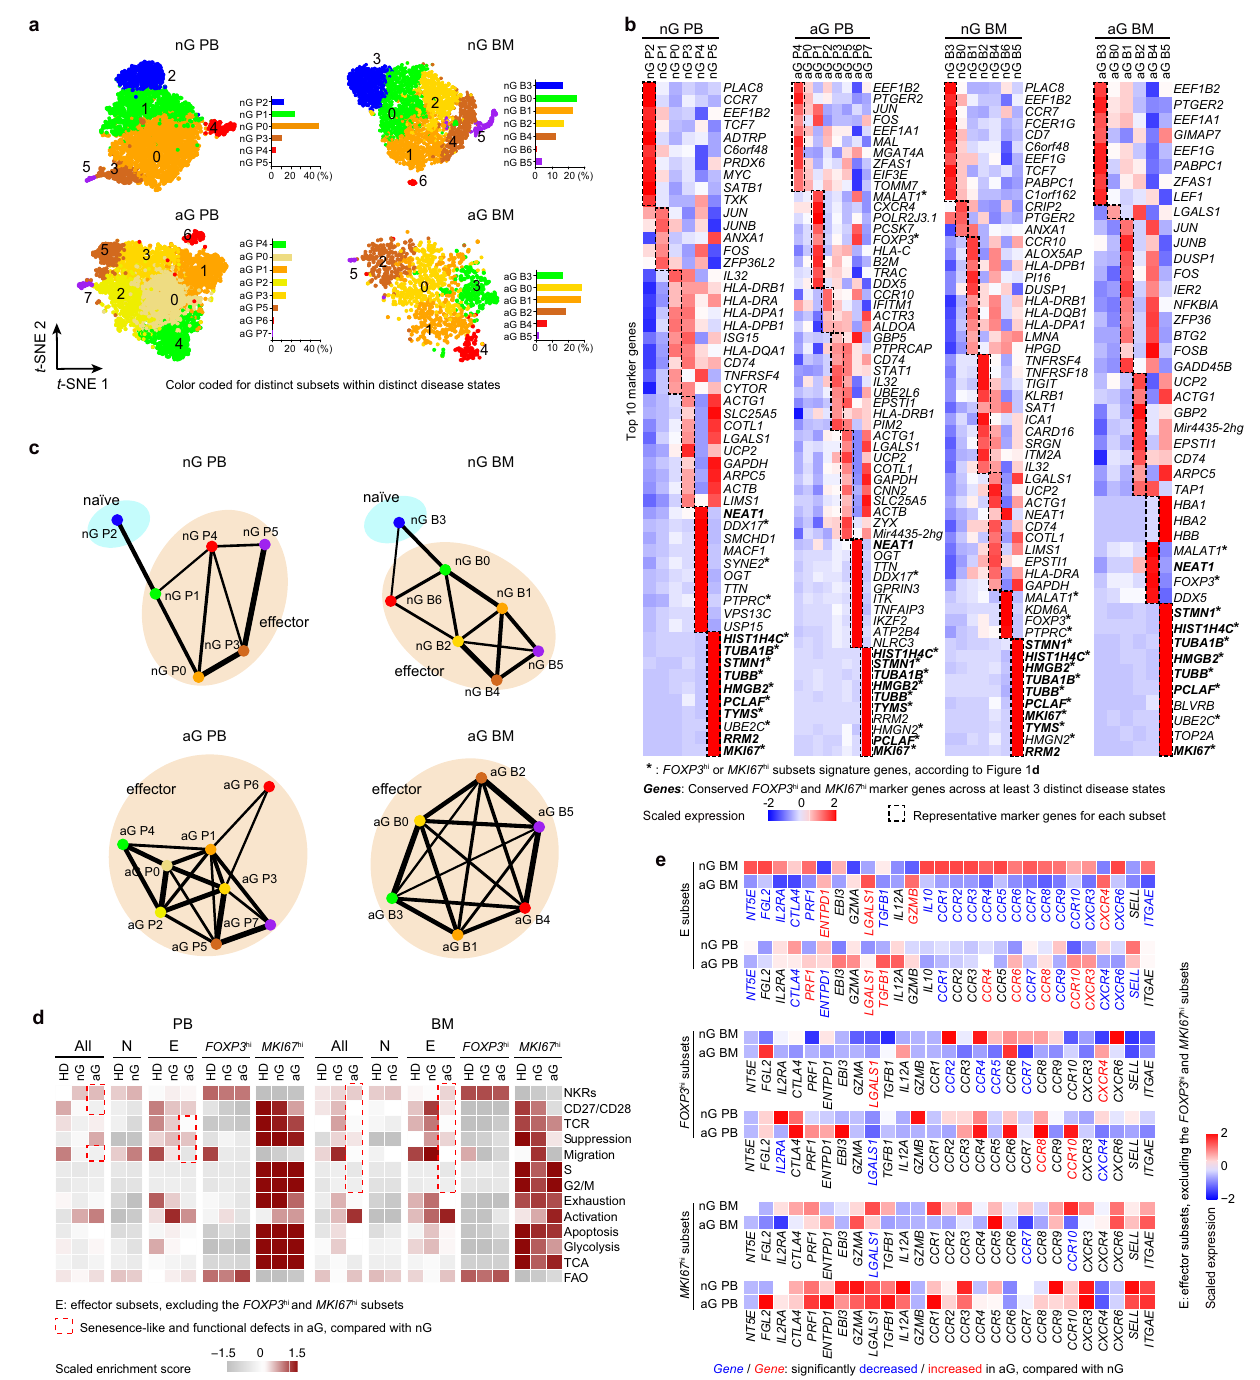
Fig. 6 T reg subsets in allo-HSCT patients with or without aGVHD. a t -SNE of single-cell transcriptomes of T reg cells from allo-HSCT patients, numbers